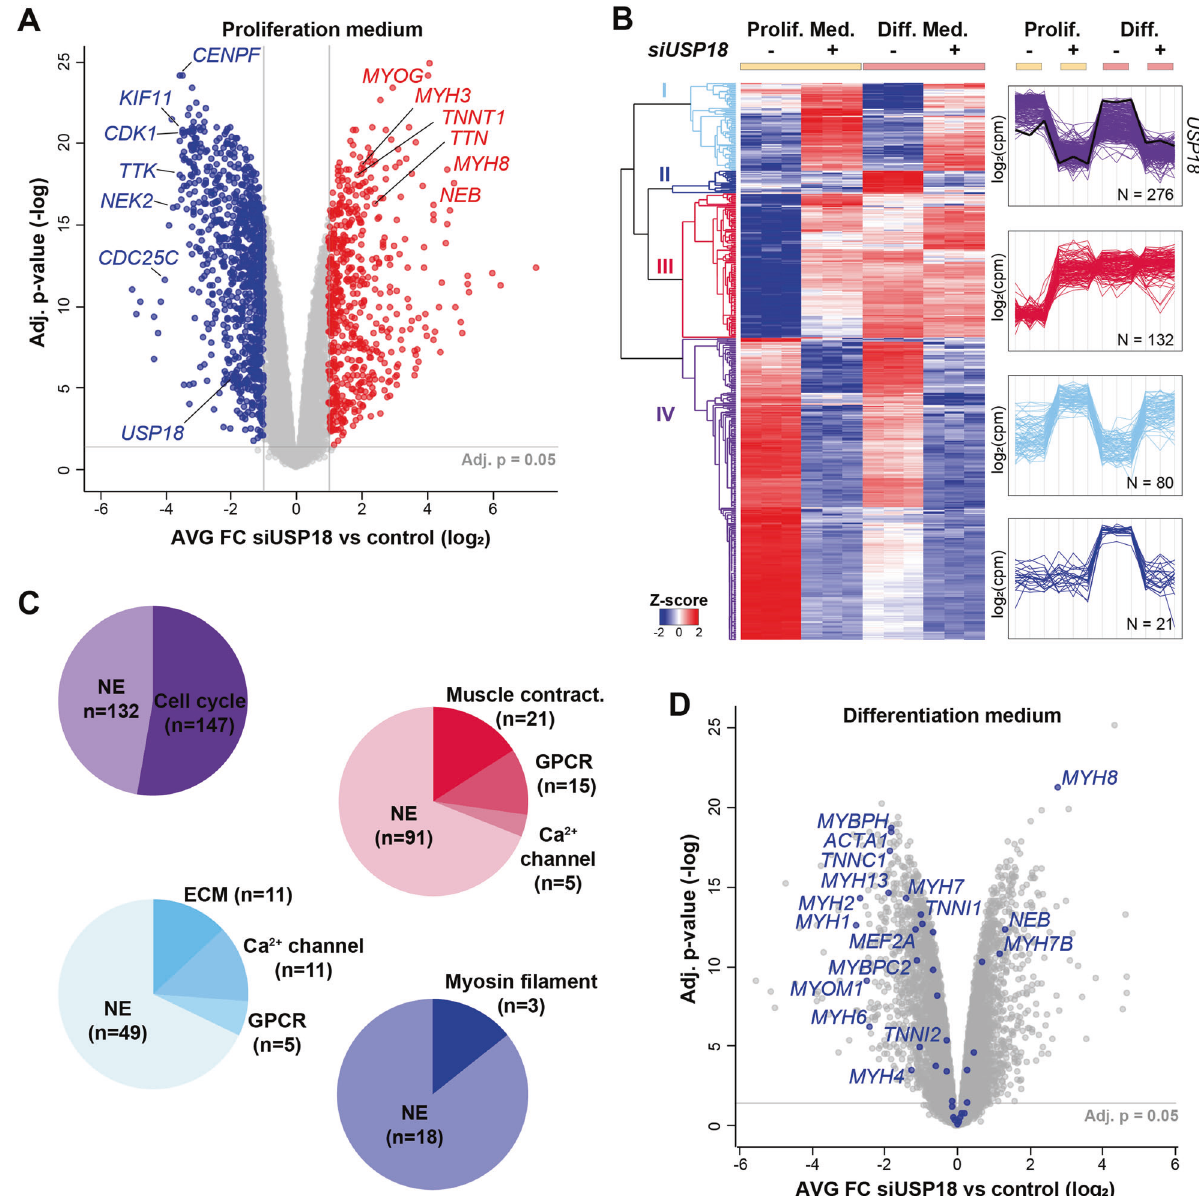
Fig. 5 USP18 KD leads to reduced expression of cell cycle genes and dysregulates muscle genes. A Volcano plot of transcriptome shows mRNA average fold changes in USP18 KD cells versus lipofectamine treated control cells cultured in proliferating medium ( N = 3). A fold change (FC) cut off (>|2|) and the statistical signi fi cance ( p < 0.05, FDR) are indicated. Genes surpassing these thresholds are depicted in blue (FC < − 2) or red (FC > 2). B Heatmap shows hierarchical clustering of the most affected genes that surpassed the selection criteria (FC > |4|, Adj. p value < 0.05) of the following comparisons: Control vs. siUSP18 cultured in proliferating or differentiating medium. Adjacent plots show expression pro fi les of the four largest clusters depicted in cyan (I) blue (II), red (III) or purple (IV). The USP18 expression pro fi le is marked with a black line. C Pie charts show the enriched gene networks per cluster. D Volcano plot shows mRNA average fold change of USP18 KD cells cultured in differentiation medium for 24 h. Myogenic genes are highlighted in blue. Results in this fi gure were obtained using immortalized cell